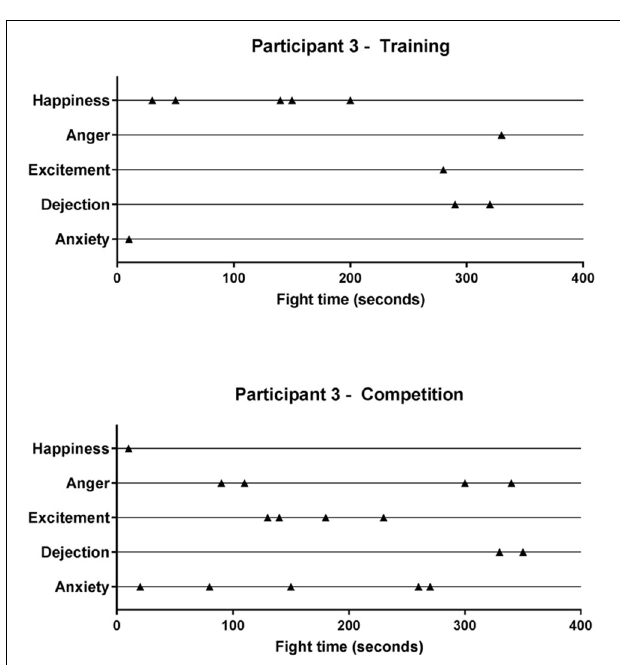
FIGURE 8 | Exemplar data for the temporal arrangement of recalled in-fight emotions for training and competition